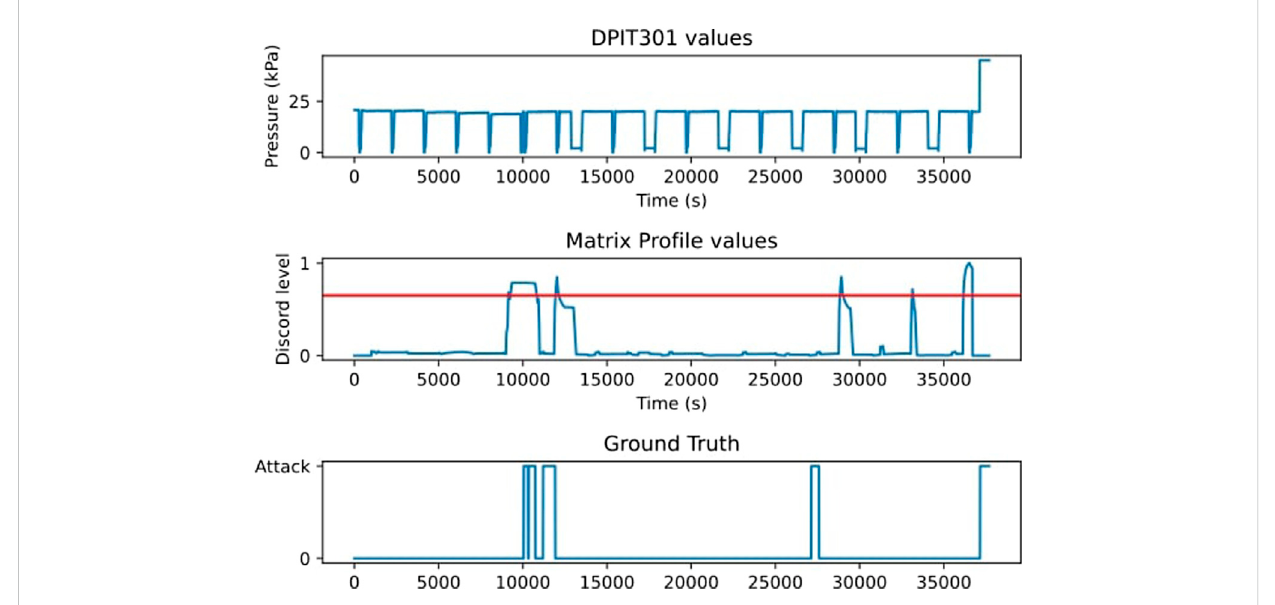
FIGURE 1 The matrix pro fi le algorithm applied to the DPIT 301 sensor and the ground truth of the attacks (Inoue et al.,